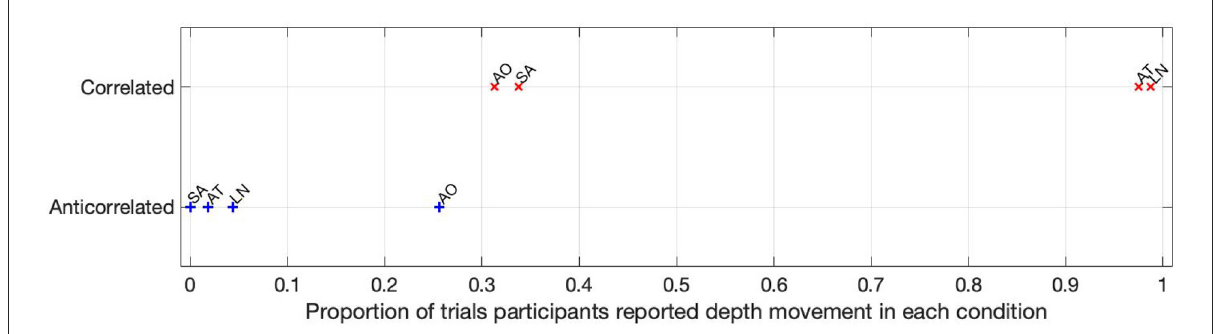
FIGURE5 The depth movement perception ratio for each participant in each condition. The labels next to the data points are individual participant codes.